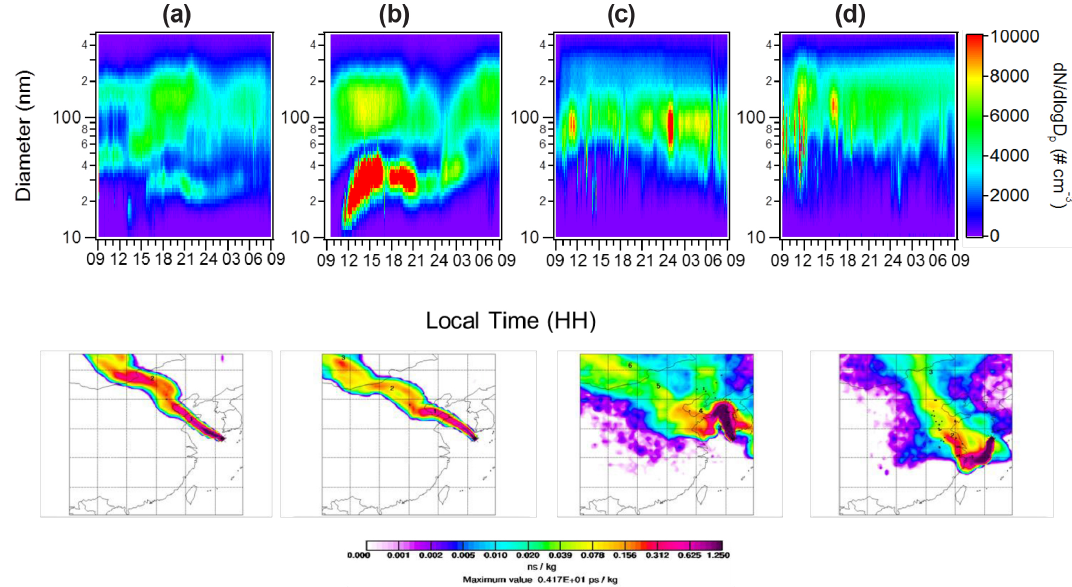
Figure 4. Comparison of particle number size distribution (top panels) and air mass trajectories (bottom panels) for the 370 and 880nm groups. (a) 3 January and (b) 14 February are included in the 370nm group, and (c) 17 April and (d) 21 May are included in the 880nm group. Particle number concentrations were measured by SMPS. Air trajectories were obtained by Flexpart model footprint images in (Stohl et al., 2005; http://zardoz.nilu.no/~andreas/STATIONS/GOSAN/index.html). The model output (skg − 1 ) is a potential emission sensitivity distribution of 40000 particles released in a particular grid cell at the measurement location during the measurement interval and followed backward in time. This is considered proportional to the particle residence time in that